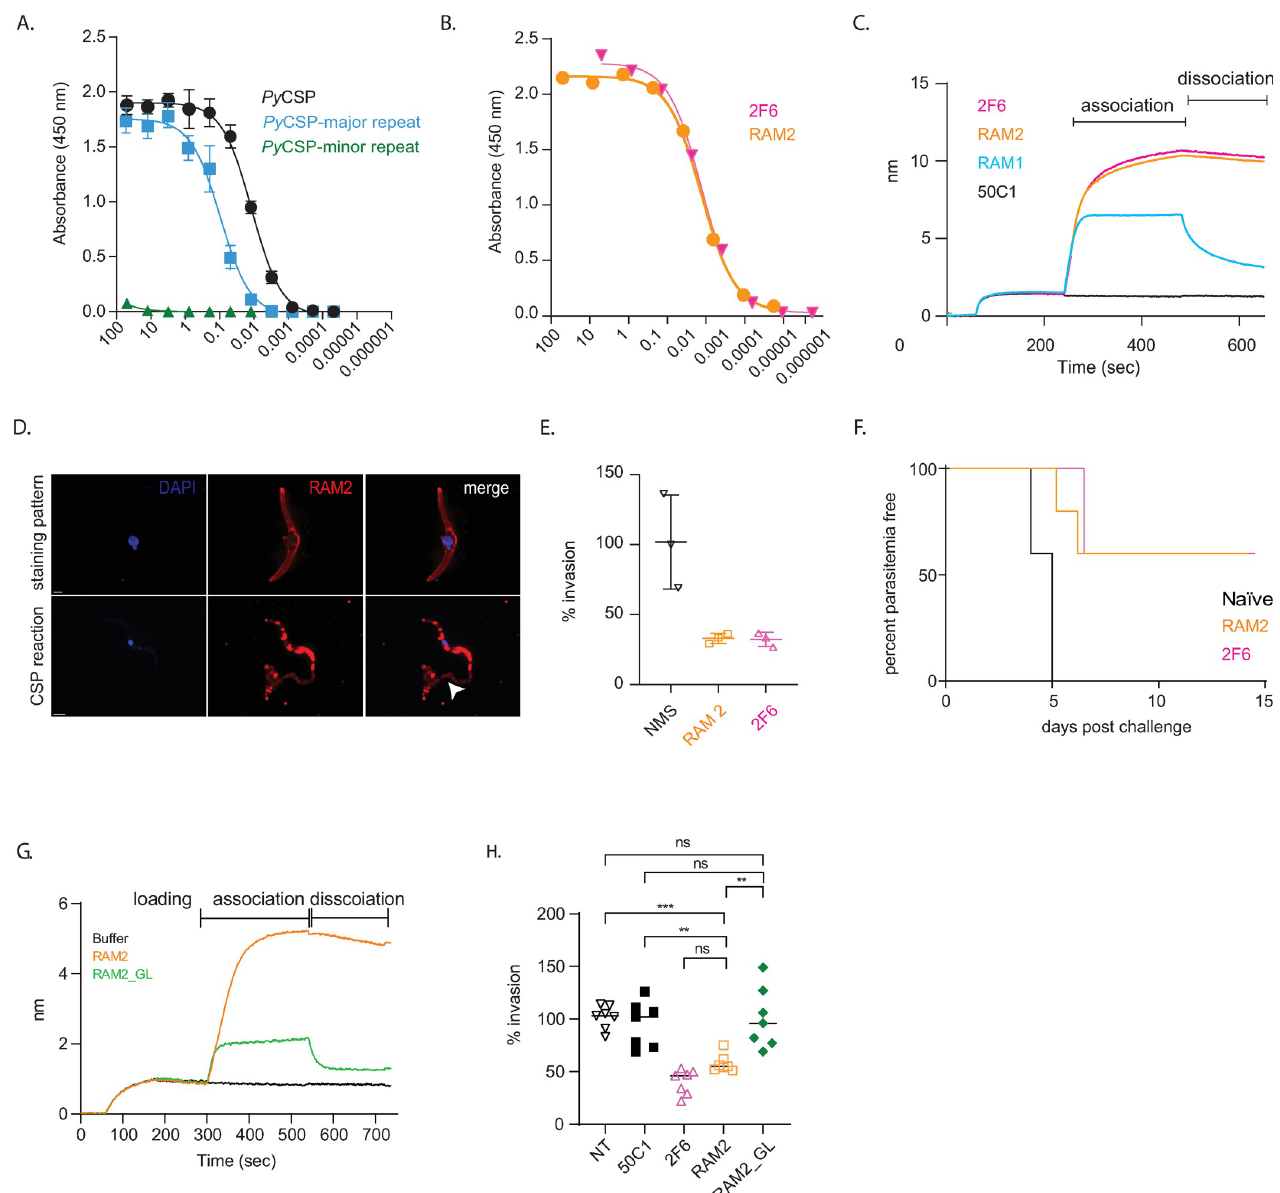
Fig 3. Py CSP mAb RAM2 avidly binds to major repeat regions of Py CSP and provides sterile liver stage protection from the pathogen. A. ELISA showing the binding of RAM2 to the Py CSP full length protein (black), the major repeat peptide (blue) but not to the minor repeat peptide (green). B. ELISA showing the EC 50 of RAM2 (orange) and 2F6 (pink) binding to Py CSP full length protein The ELISA data in Fig 3A and 3B are derived from three technical replicates. C. Biotinylated- Py CSP (5 μ g) derivatized streptavidin biosensors were incubated in different mAbs (RAM1 (cyan), RAM2 (orange) 2F6 (pink) and 50C1 (black), 5 μ g each) and the association and dissociation kinetics were assayed by Octet-BLI D. Representative immunofluorescent images of P . yoelii sporozoites incubated with mAb RAM2 (10 μ g) for 10 min. Py CSP mAb, 2F6, is used as control for CSP trailing assay and DAPI is used to stain the nucleus of the sporozoites. The arrowhead points to the regions of CSP reaction or shedding (CSPR). E. Freshly isolated sporozoites were pre-incubated with (10 μ g) of RAM2 (orange), 2F6 (pink), and normal mouse serum (black) antibodies for 10 mins. Hepa 1–6 cells were infected with antibody-treated sporozoites for 90 mins to assess hepatocyte entry. The data here represents the percentage of hepatocytes that were CSP-positive as evaluated by flow cytometry. The data represents mean values ± SE from three independent experiments: n = 3. p values were determined by comparing each treatment to untreated using one-way ANOVA for multiple comparisons tests. F. BALB/cJ were injected with 150 μ g of RAM2 (orange) or 2F6 (pink) intraperitoneally. Na ï ve BALB/cJ (black) mice injected with PBS is used as control. After 24 h, mice were challenged with bites from fifteen P . yoelii infected mosquitoes and patency was assessed from day 4 through day 14. Kaplan-Meier survival plot represents percentage parasitemia free mice over time, including 10 mice from 2 independent experiments. G. Biotinylated- Py CSP (5 μ g) derivatized streptavidin biosensors were incubated in different mAbs (RAM2 (orange), RAM2_GL (green) and 10xkb buffer (black), 5 μ g each) and the association and dissociation kinetics were assayed by Octet-BLI. H. Freshly isolated sporozoites were pre-incubated with (10 μ g) of RAM2 (orange), 2F6 (pink), RAM2_GL (green), 50C1 (black squares) and normal mouse serum (black inverted triangles) antibodies for 10 mins. Hepa 1–6 cells were